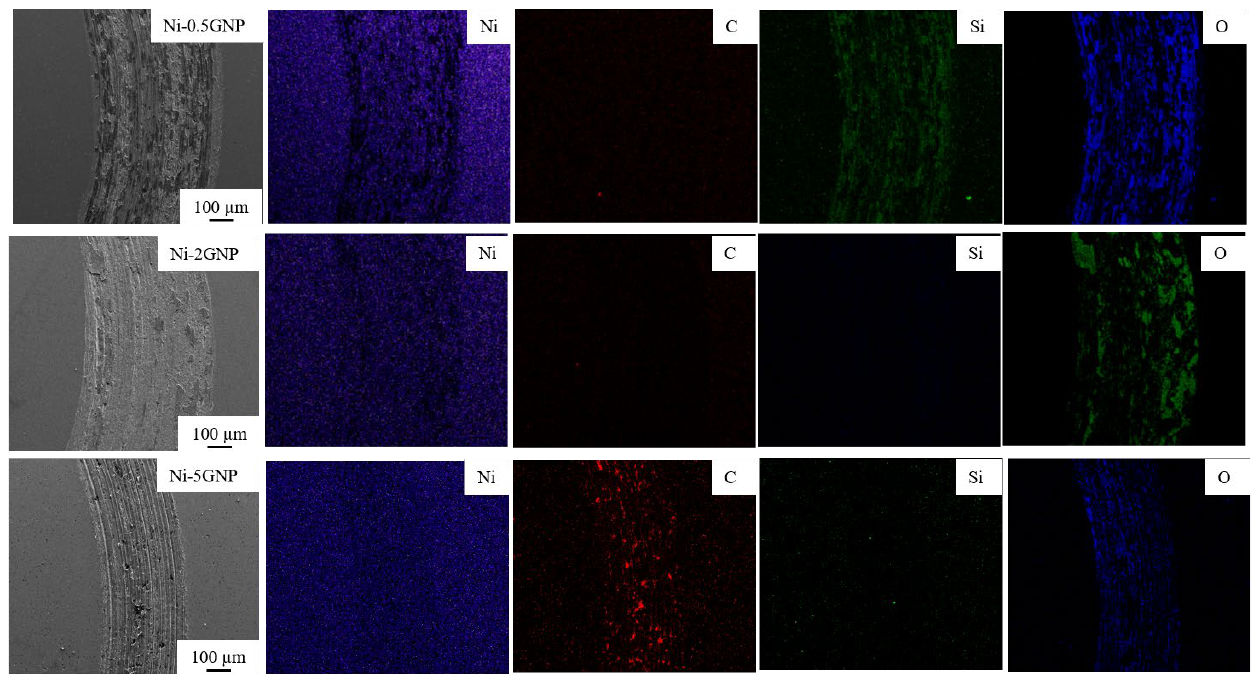
Figure 9. EDS maps of wear track on Ni-GNP composites.